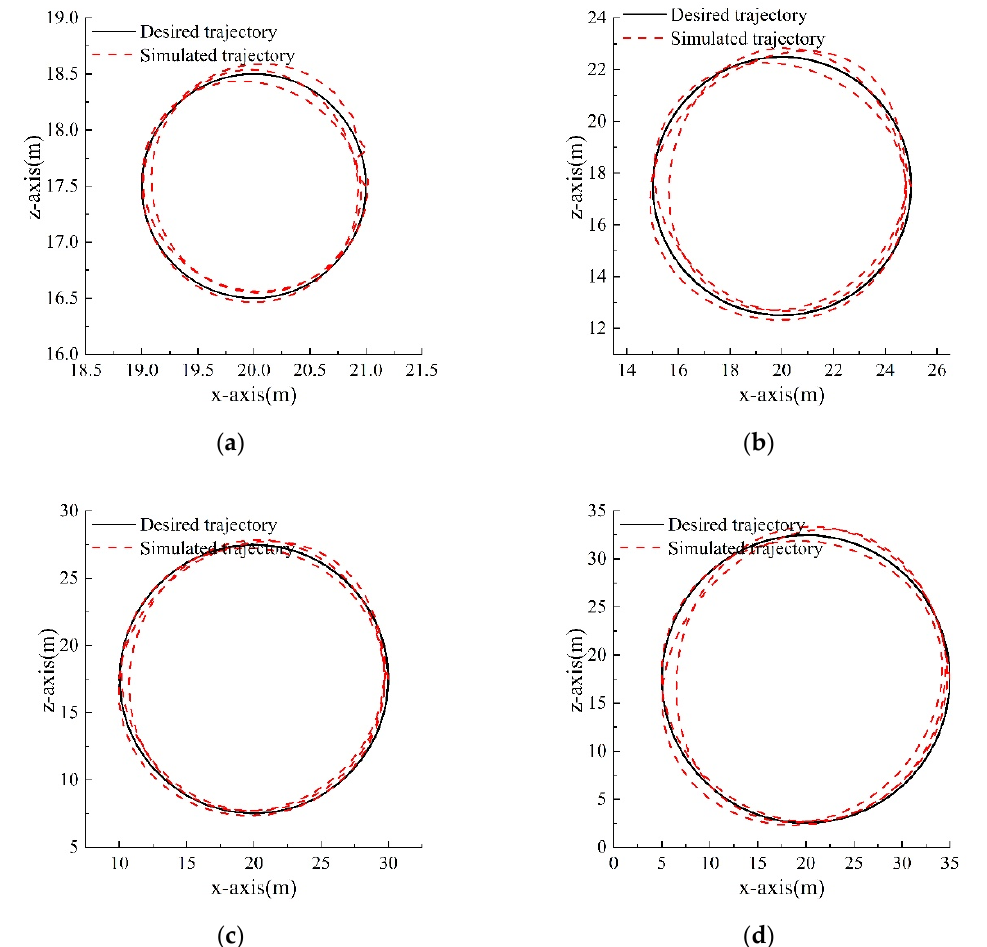
Figure 7. Trajectory tracking at different speeds: ( a ) Low-speed motion v = 0.6 m/s; ( b ) Medium speed motion v = 3.1 m/s; ( c ) High-speed motion v = 6.3 m/s; ( d ) Ultra-high-speed motion v = 9.4 m/s.